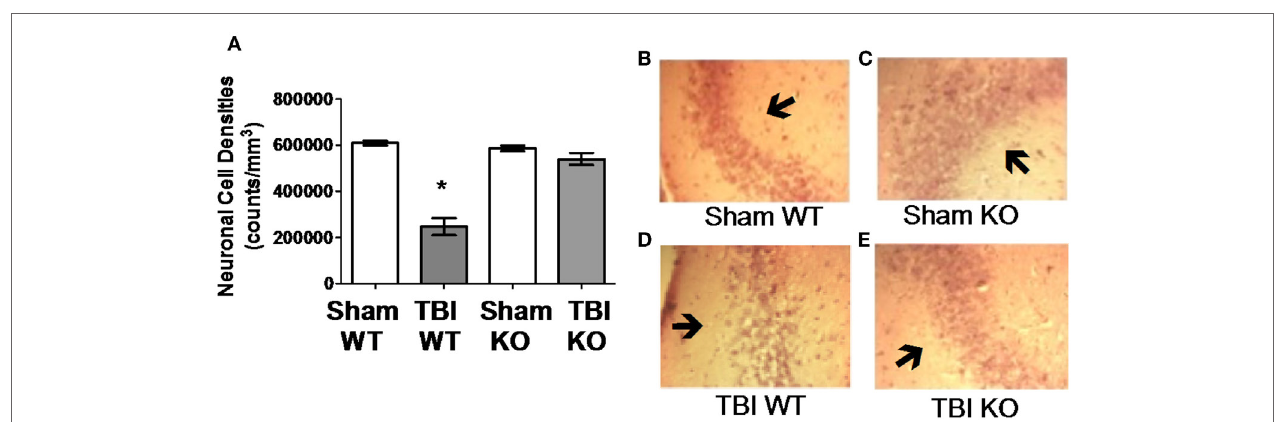
knockout resulted in reduced neuronal loss. Representative micrographs from the brains of Sham WT, Sham KO, TBI WT, and TBI KO animals are shown in (B–e) , respectively (mean ± SEM, Bonferroni’s multiple comparison test P < 0.05, N = 10 animals/group, * TBI WT vs. Sham WT, Sham KO and TBI KO) (48). Data from cited publication adapted for graphic